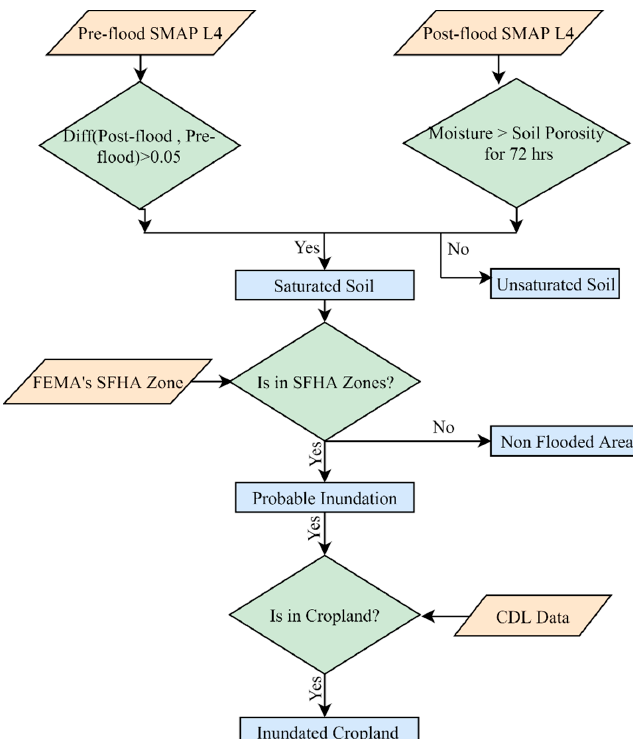
Figure 1. Methodological flow diagram for inundation mapping in cropland from SMAP L4